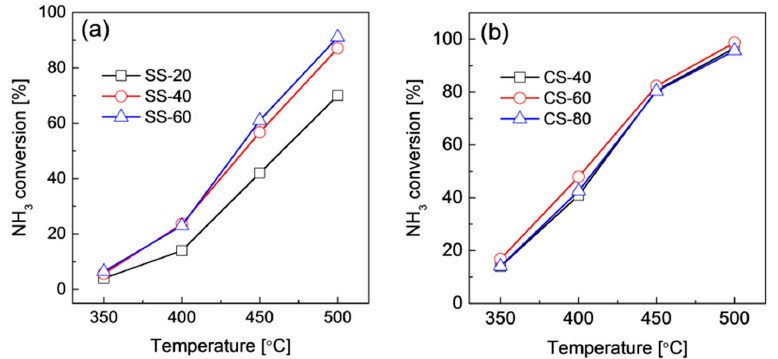
Figure 6. Catalytic performance of Ru/graphene nanocomposites prepared in the SS ( a ) and CS ( b ) systems. GHSV = 20,000 mL ∙ h − 1 ∙ g cat − 1 .